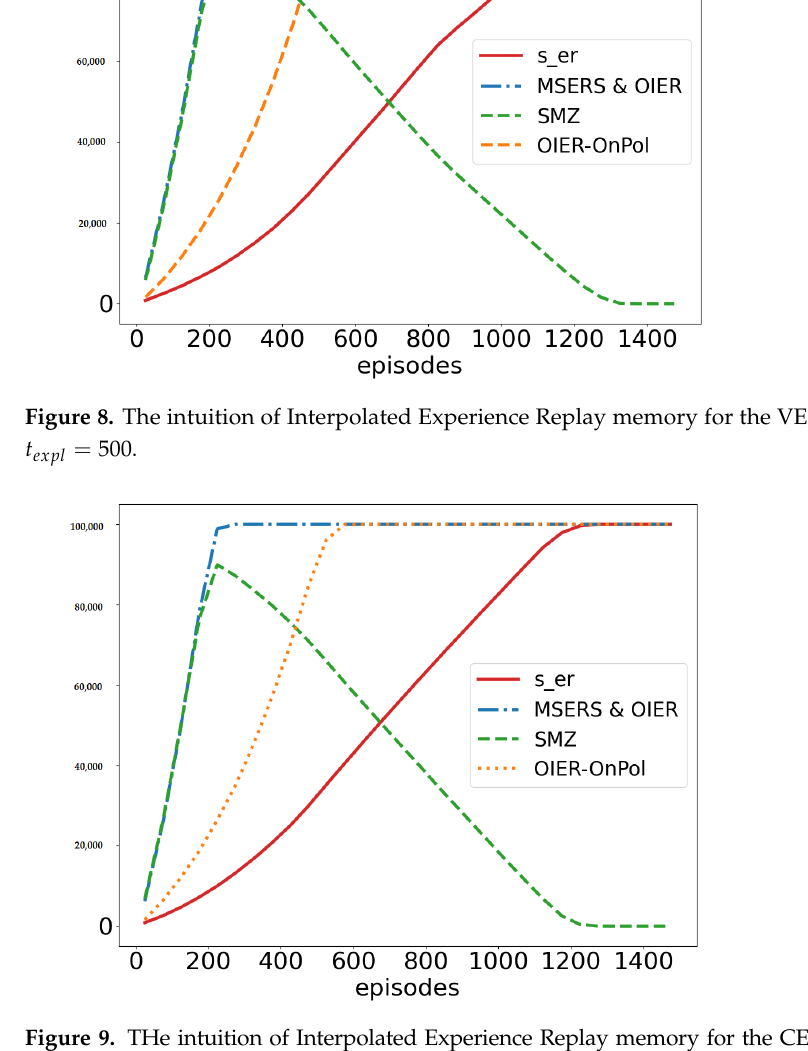
Figure 9. THe intuition of Interpolated Experience Replay memory for the CE state encoding and t expl =